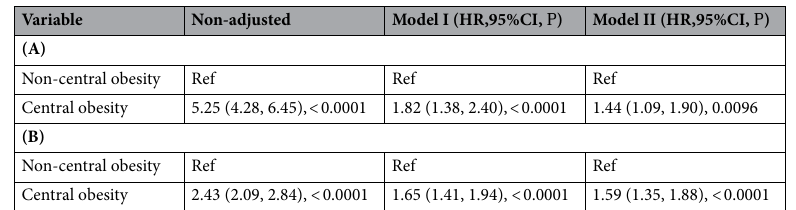
Table 5. Association between central obesity and incident diabetes in different models of the original and the weighted cohort. (A) In the original cohort; (B) in the weighted cohort. Crude model: we did not adjust for other covariates. Model I: we adjusted for age, BMI, gender, smoking status, ethanol consumption, regular exerciser, SBP, DBP. Model II: we adjusted for age, BMI, gender, smoking status, ethanol consumption, regular exerciser, SBP, DBP, ALT, AST, GGT, HbA1c, FPG, TC, TG, HDL-C. HR hazard ratios, CI confidence interval, Ref